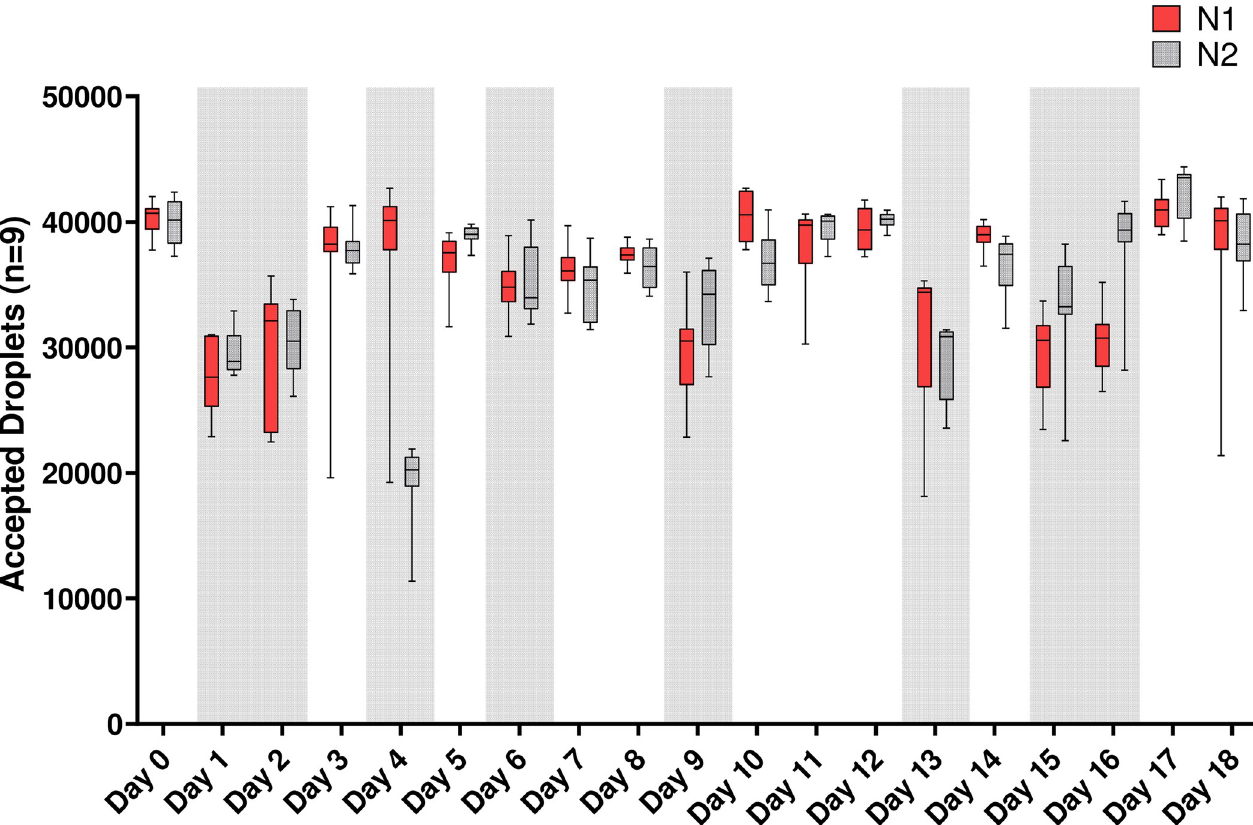
Fig 4. Box and whisker plots of the mean, minimum, and maximum of accepted droplets generated per genetic target (N1 or N2) per day across 9 samples (3 WWTP and 1 Field Blank heat pasteurized and unpasteurized for a total of 8 samples plus 1 no matrix control for a total of 9 samples analyzed). Days shaded in light gray represent data generated by a new analyst; unshaded days represent data generated by an experienced analyst.